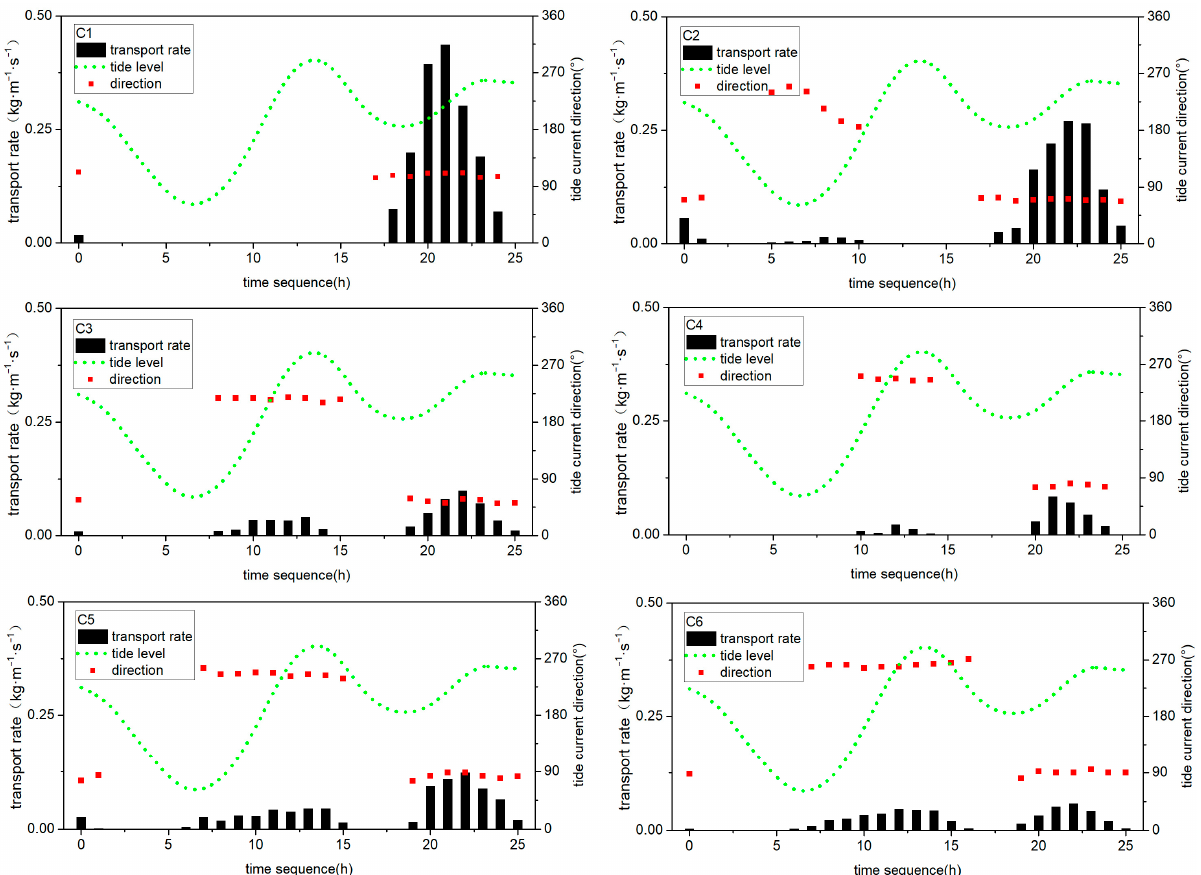
Figure 10. Time sequence diagrams of sediment transport rates at the six observed stations. The green line represents the tidal level. The red point represents the tidal current direction. The black bar shows the bedload transport rate.